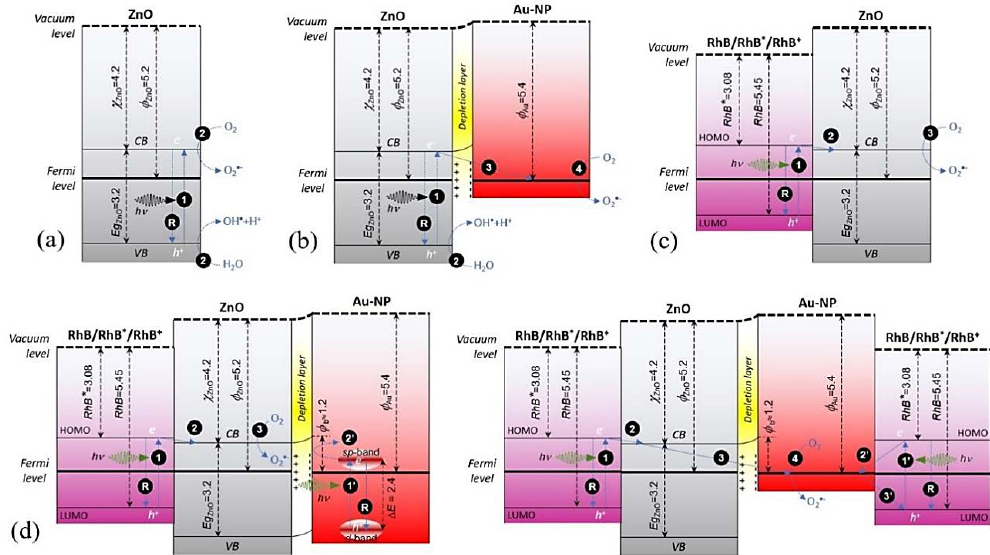
Figure 8. Electronic band schemes showing the different pathways leading to generation of O 2 • −